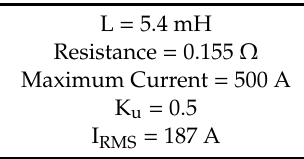
Table 2. Inductor and resistor parameters.